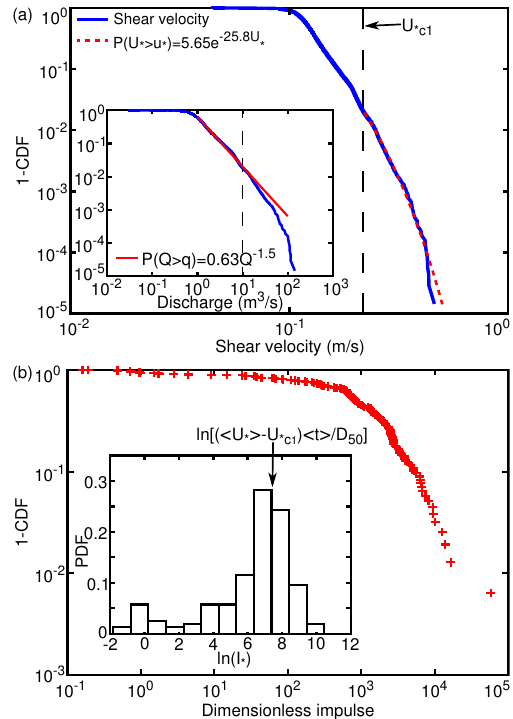
Figure 6. (a) Frequency magnitude distribution of shear velocity for the main channel of the Mameyes river. The dashed red line rep- resents an exponential function fit to the distribution for U ∗ >U ∗ c . (a) Inset: magnitude frequency distribution of discharge. The red line represents a power-law relationship, and the vertical dashed black line is the location of the threshold of motion ( U ∗ c1 ). (b) Mag- nitude frequency distribution of the dimensionless impulse ( I ∗ ). (b) Inset: PDF of ln (I ∗ ) , where (cid:104) U ∗ (cid:105) is the average value of the dis- tribution of U ∗ >U ∗ c1 , (cid:104) t (cid:105) is the average duration of a flood above the threshold of motion for the duration of the study, and D 50 is the median grain size of the tracer